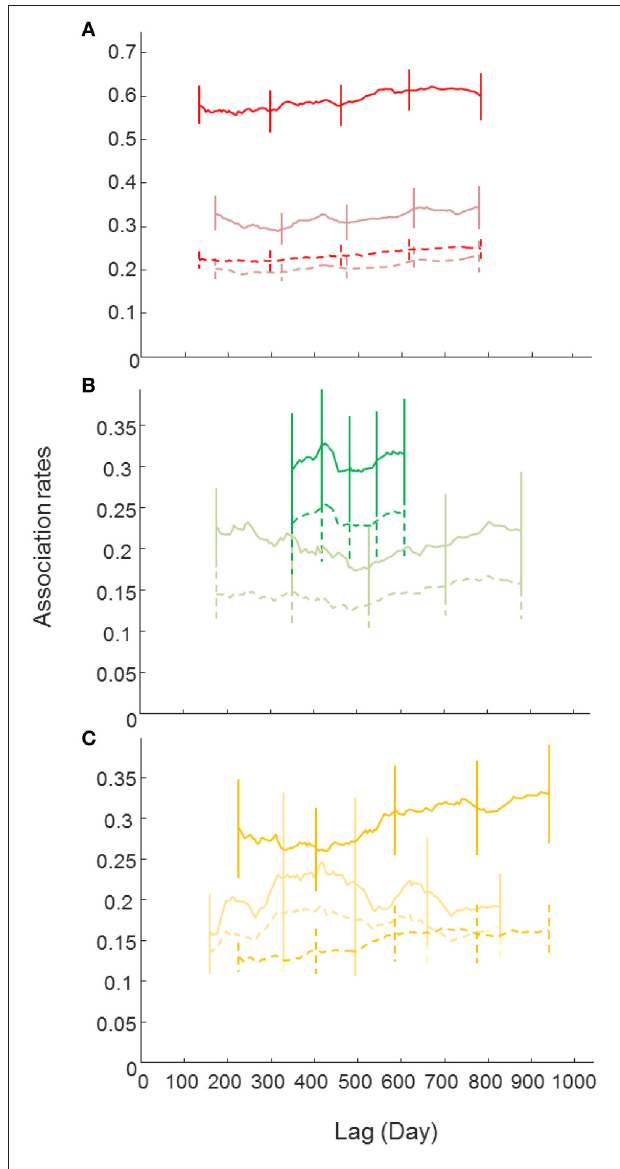
FIGURE 4 | Lagged association rates (LAR) for males and females (bland color) bottlenose dolphins of each community [(A)-ComB, (B)-ComC and (C)-ComD]. The null association rate (dash lines) and jackknife error bars are shown. Note that the LAR for ComA couldn’t be estimated because of small sample